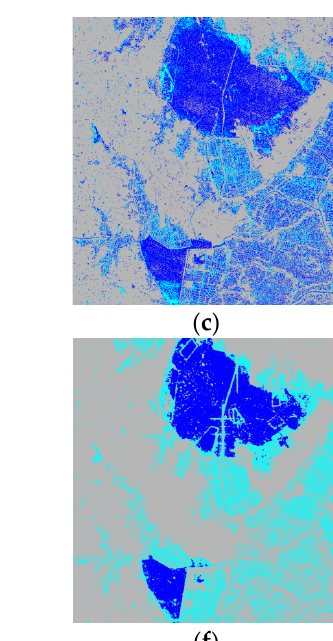
Figure 7. Feature classification map of Yancheng coastal wetland. ( a ) HH—Extraction results; ( b ) HV—Extraction results;